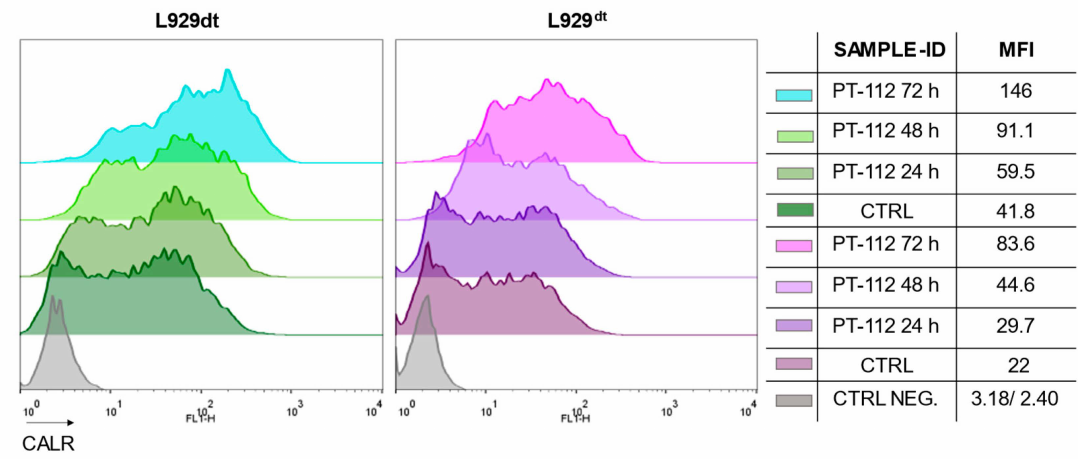
Figure 10. CRT exposure upon PT-112 treatment. Representative plots are shown. CRT exposure was analyzed in L929dt or L929 dt cells upon treatment with 10 µ M PT-112 for the time indicated. Grey histograms correspond to the labeling with the secondary antibody alone and are considered as negative controls (CTRL NEG.), while control labelings correspond to the basal labeling of untreated cells (CTRL). Representative plots are shown.